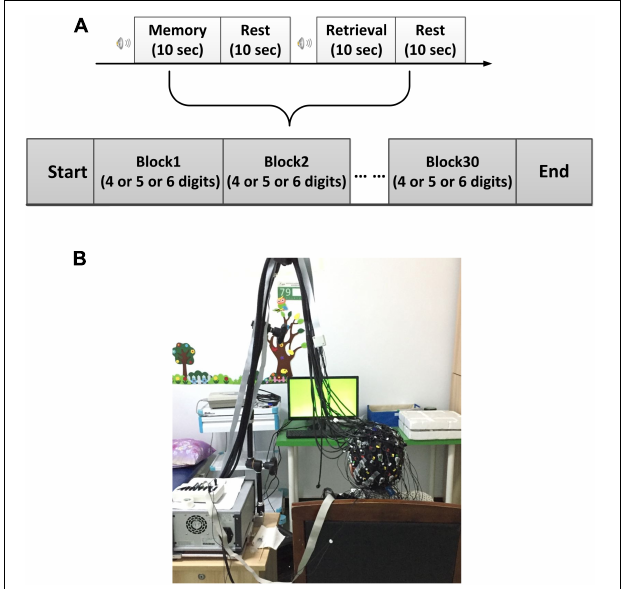
FIGURE 1 | Experimental design. (A) The digit verbal span task used in this study. (B) Illustration of experimental